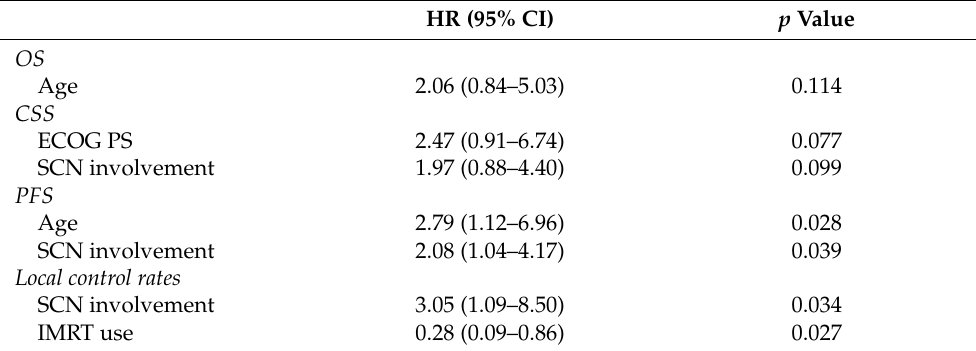
Table 3. Multivariate analysis of OS, CSS, PFS, and LC rates.